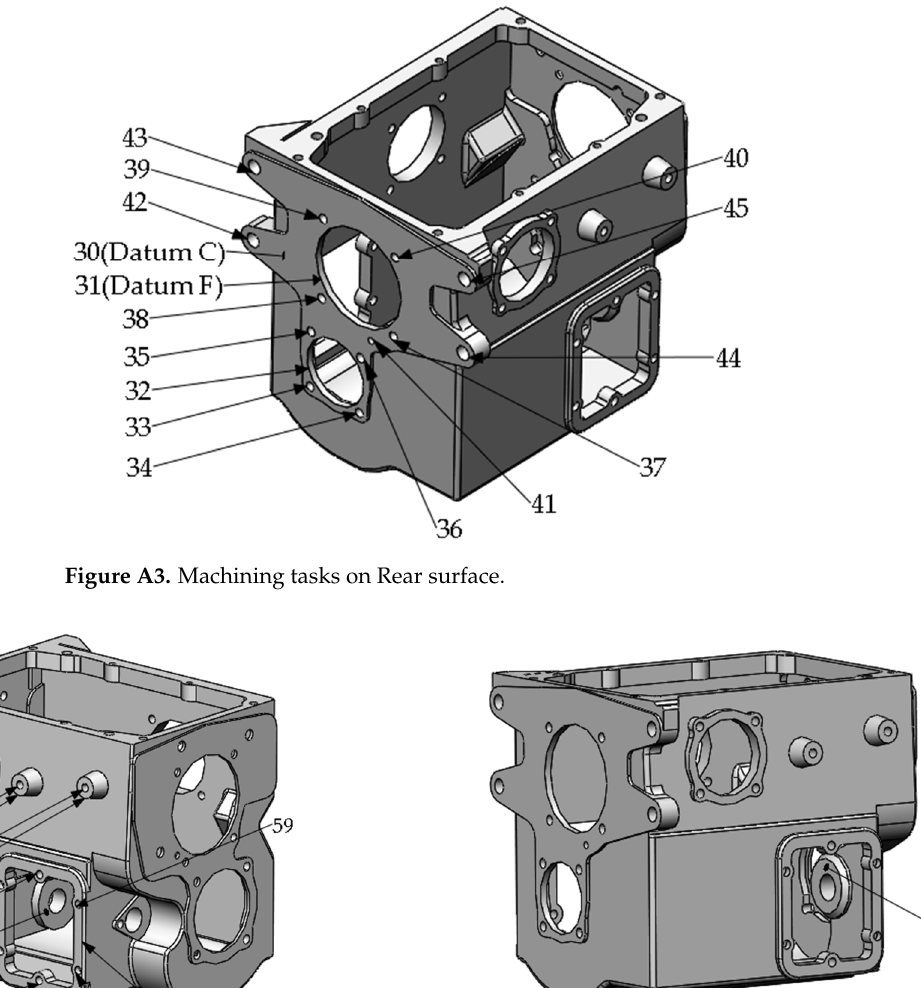
Figure A2. Machining tasks on Front surface.